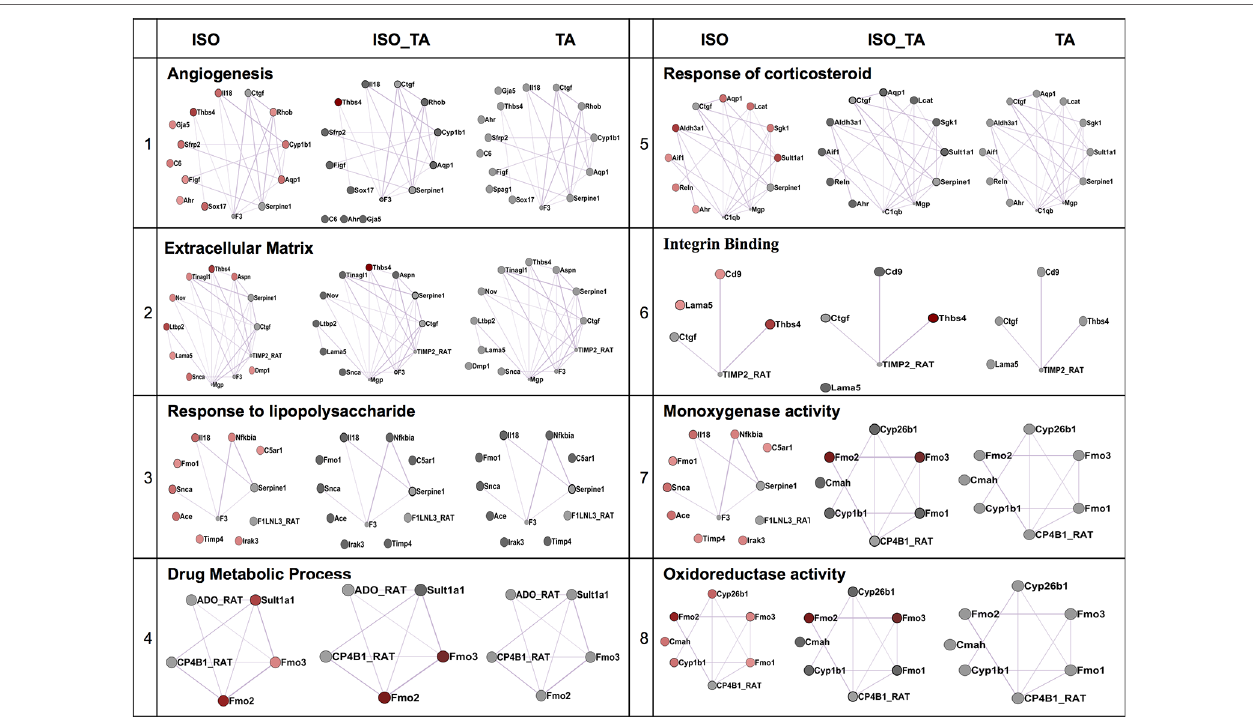
FIgURE 3 | Comparison of enriched non-redundant biological processes represented as “ degree sorted circular view ” networks of upregulated genes in ISO group extracted from “ GeneMANIA ” (Cytoscape plugins) along with ISO_TA and TA group overlaid network. Upregulated, downregulated, and undifferentiated gene represented as red node, green node, and gray node